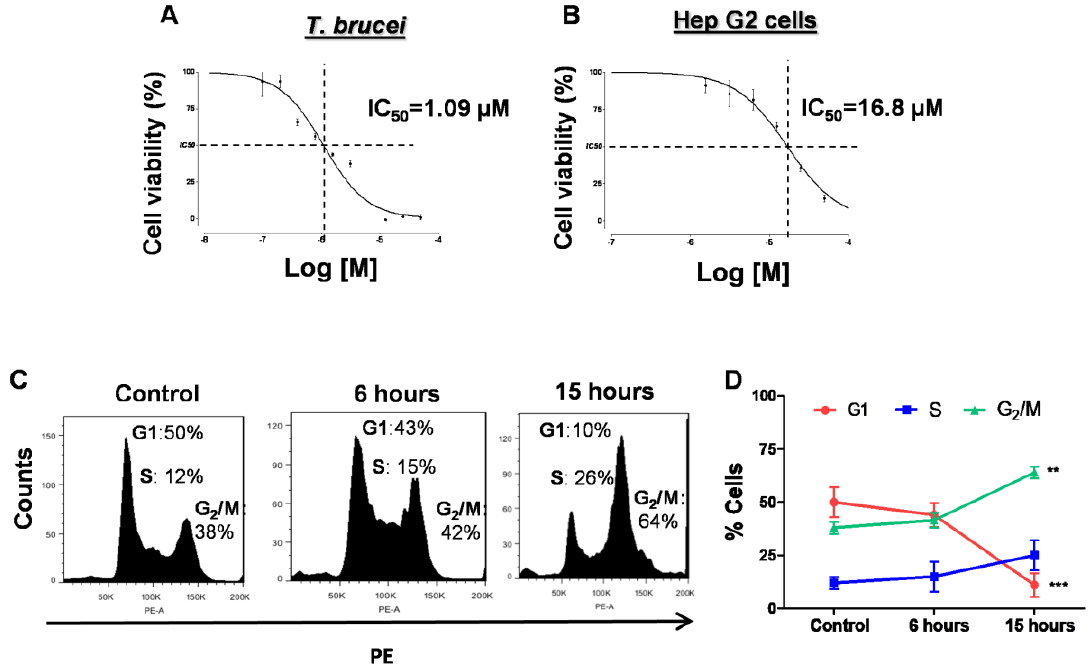
Figure 4. Curvicollide D inhibits proliferation and affects the cell cycle of bloodstream form of T. brucei. Resazurin in vitro cytotoxicity assay was used to determine the curve dose response (viability percentage versus curvicollide D concentration). The IC 50 was determined interpolation, using GraphPad software ( A ) IC 50 of T. brucei and ( B ) IC 50 of the human hepatocarcinoma cells (Hep G2) during 24 h. ( C , D ) Flow cytometry analysis of the cell cycle after 6 and 15 h of exposure to curvicollide D (1.5 µ M) or after treatment with DMSO (control). Percentages for each phase were determined using FlowJo software. (PE) phycoerythrin. Data represent mean and standard deviation from three independent experiments. Statistical significance between control and treatmens at 6 and 15 h was estimated using Student’s two-tailed t -test. p -Values were expressed as follows: ** p < 0.01 and *** p <